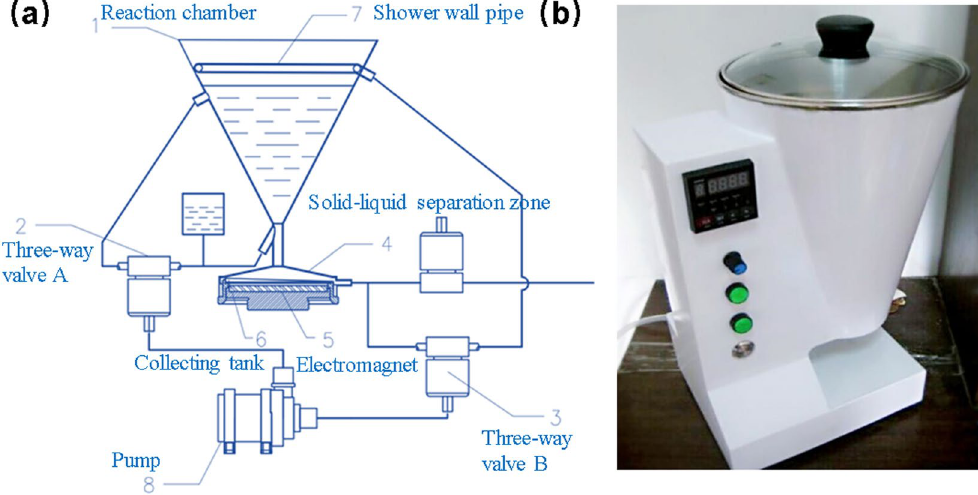
Figure 1. ( a ) Scheme and ( b ) Digital photo of the portable magnetic separator.